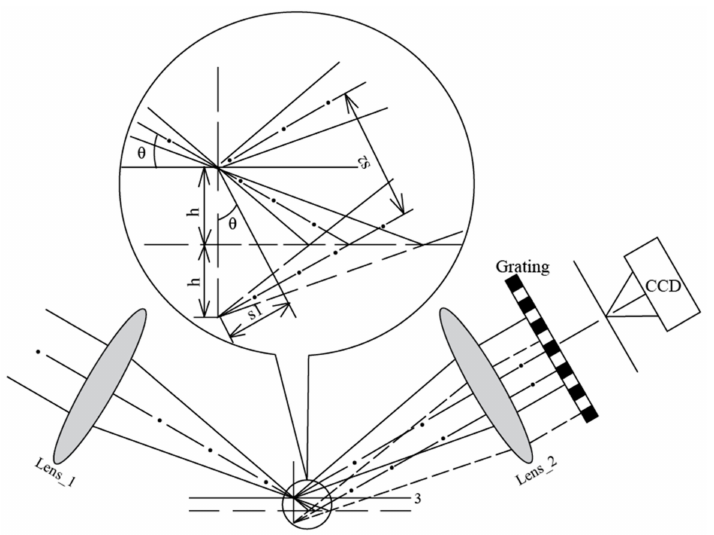
Figure 3. Illustration of defocus measurement